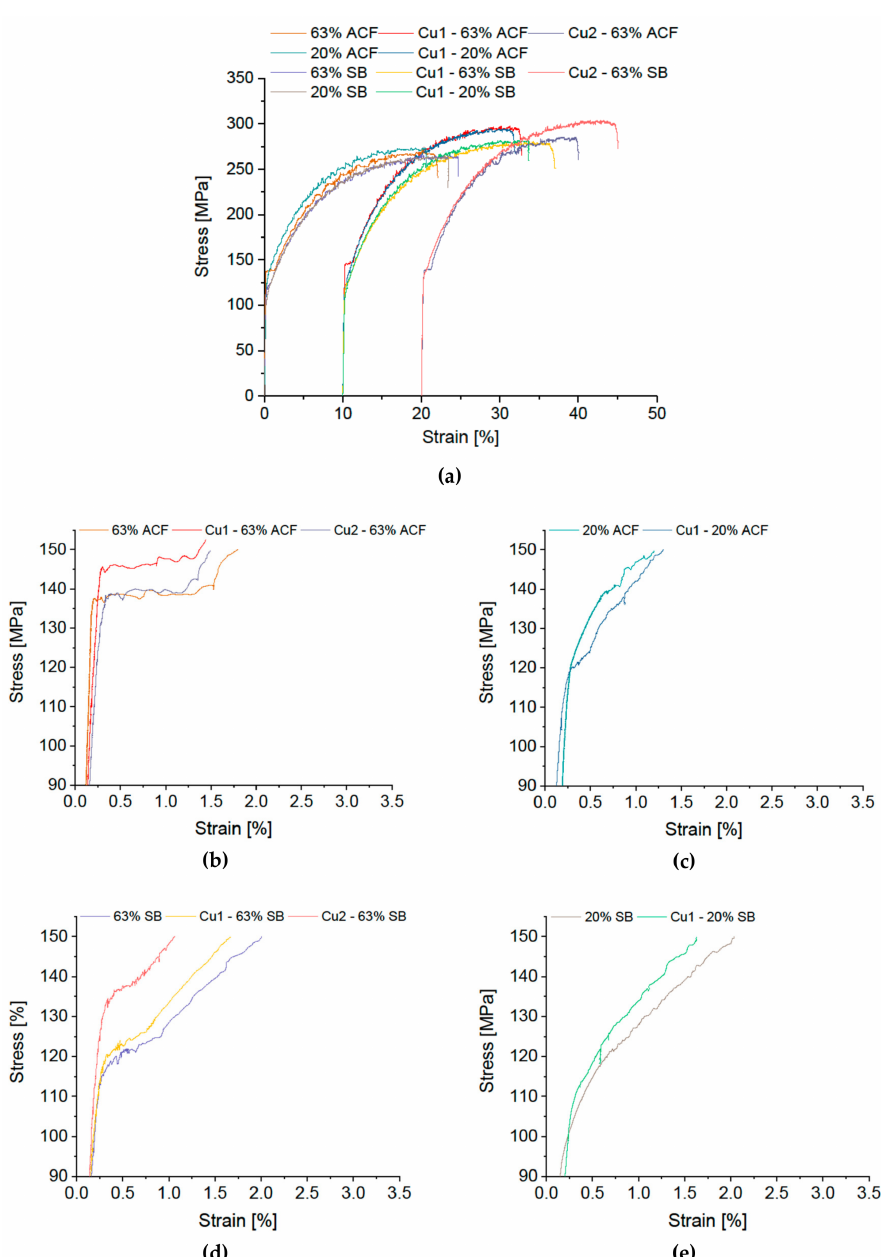
Figure 7. Stress-strain diagram of modified EN AW-5182 with di ff ering Cu content. ( a ) Overview; Details of Lüders elongation: soft annealing in ACF at 370 ◦ C with ( b ) 63% and ( c ) 20% cold rolling, salt-bath treatment at 500 ◦ C with subsequent water quenching with ( d ) 63% and ( e ) 20% cold